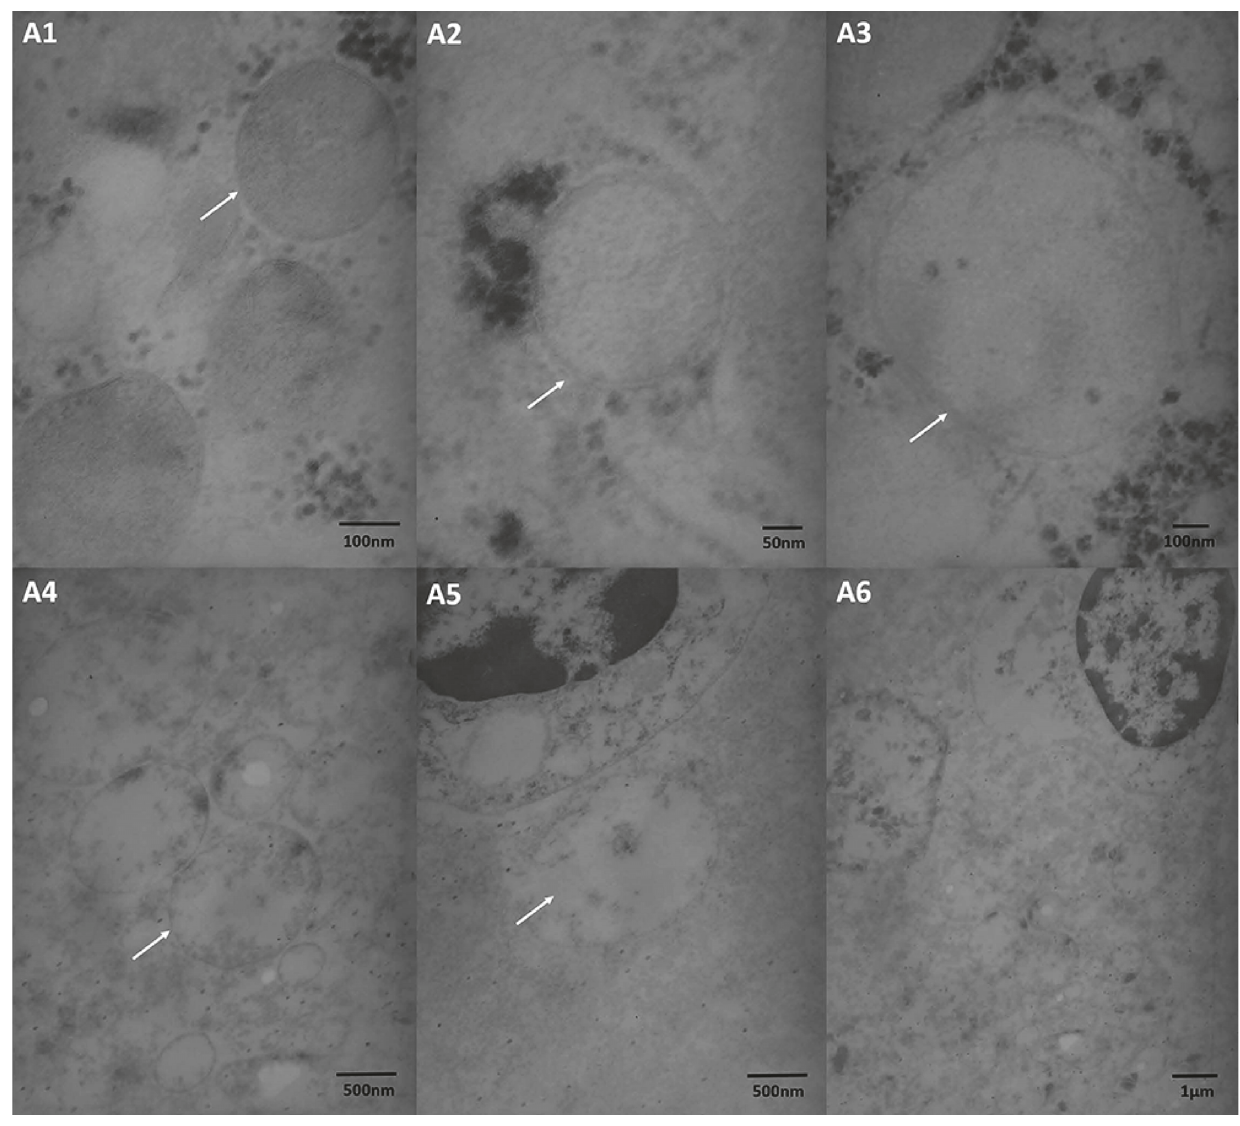
Figure 2: Mitochondrial ultrastructure at 5 different damage levels according to the Flameng classification system. A1: Level 0 (score 0) mitochondrial structure is normal and full of substrate particles (white arrow). A2: Level 1 (score 1) mitochondrial structure is essentially normal with a lack of substrate particles (white arrow). A3: Level 2 (score 2) mitochondria are markedly swollen with transparent substrate (white arrow). A4: Level 3 (score 3) mitochondrial crest is divided with transparent or thick substrate (white arrow). A5: Level 4 (score 4) mitochondria are vacuolated with divided crest, and substrate and membrane integrity have disappeared (white arrow). A6: microcellular ultrastructure vision obtained more mitochondrial